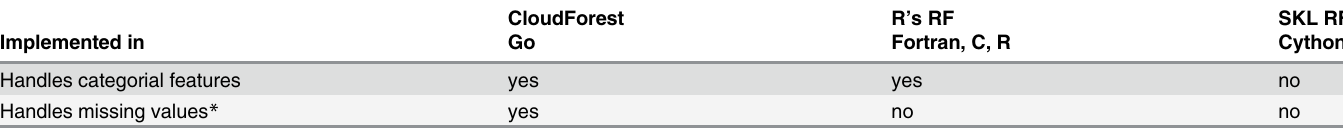
Table 1. Overview of CloudForest ’ s main features compared with R ’ s randomForest package (R ’ s RF) and scikit-learn ’ s RandomForestClassifier (SKL